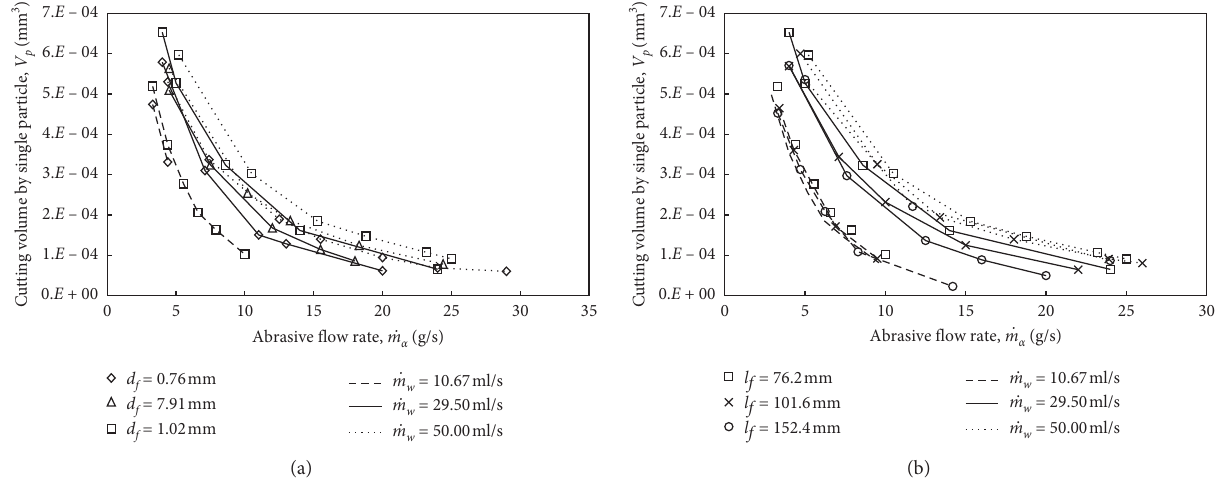
Figure 10: Cutting volume due to single-particle impact: effects of (a) focus diameter and (b) focus length.